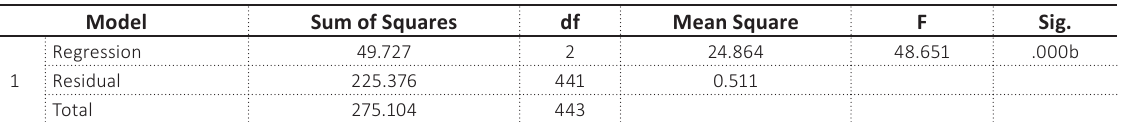
Table 5. ANOVA a for H